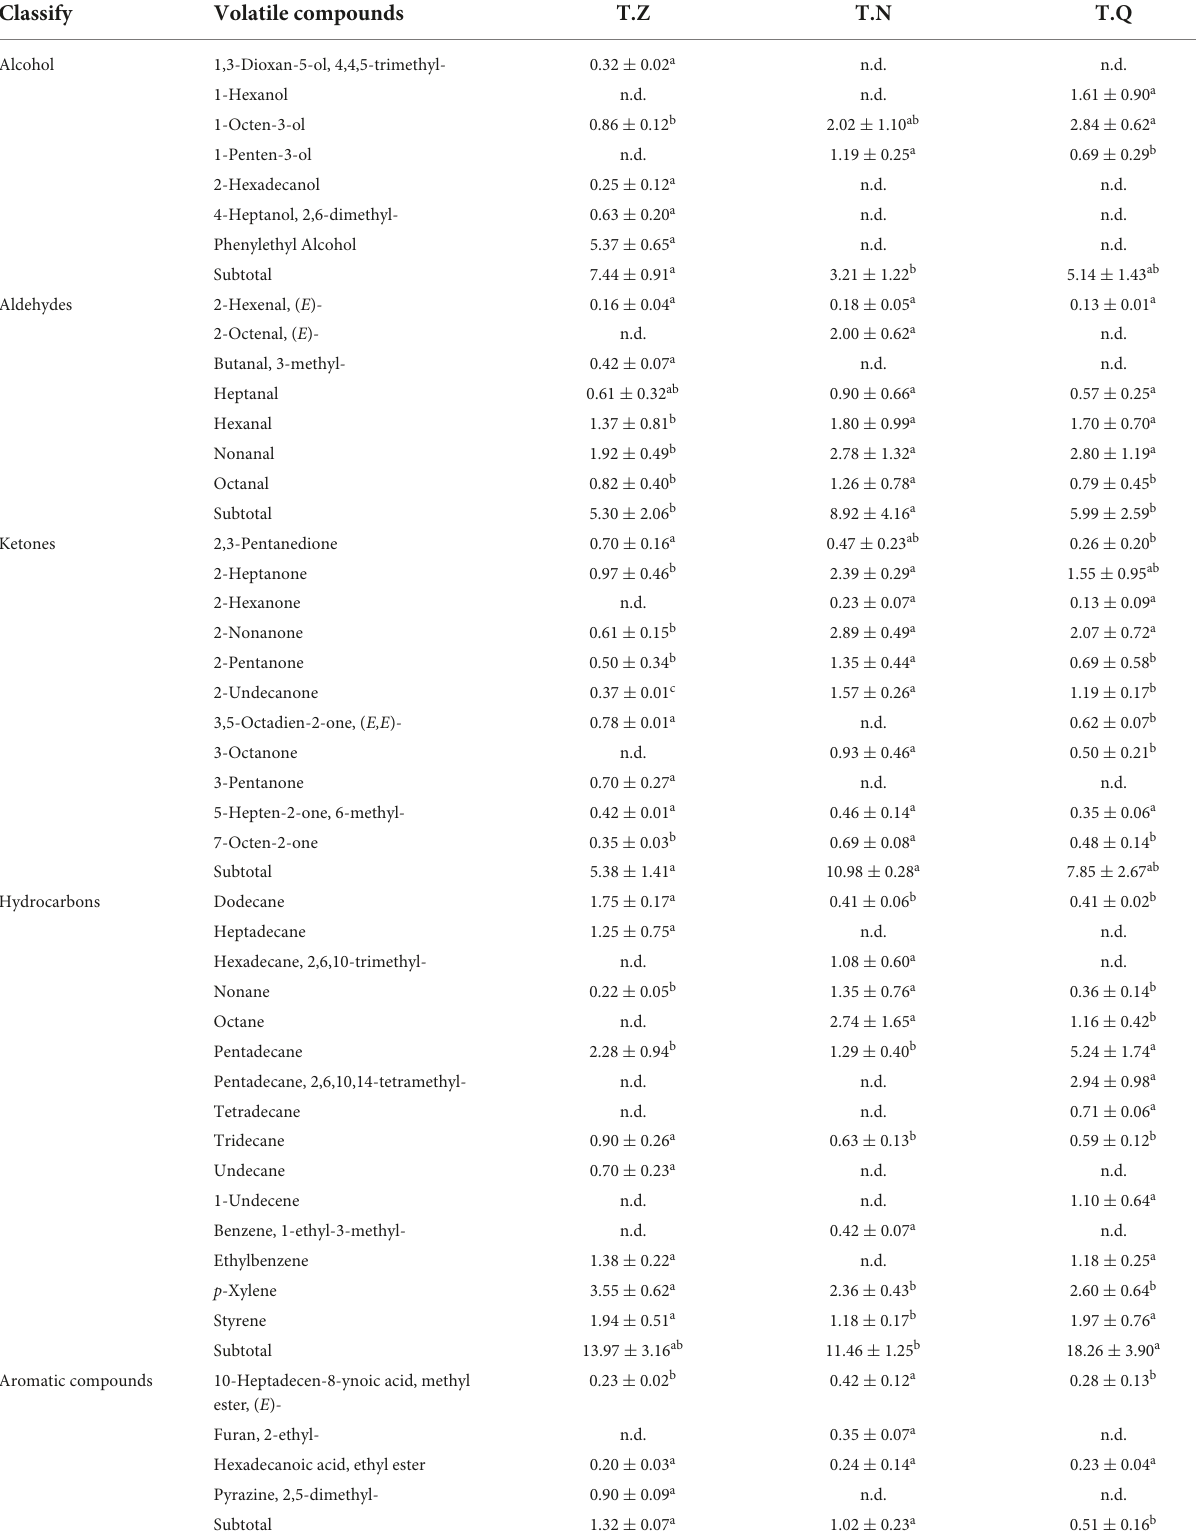
TABLE 7 Volatile compounds from three different sources were discovered in hairtail muscle